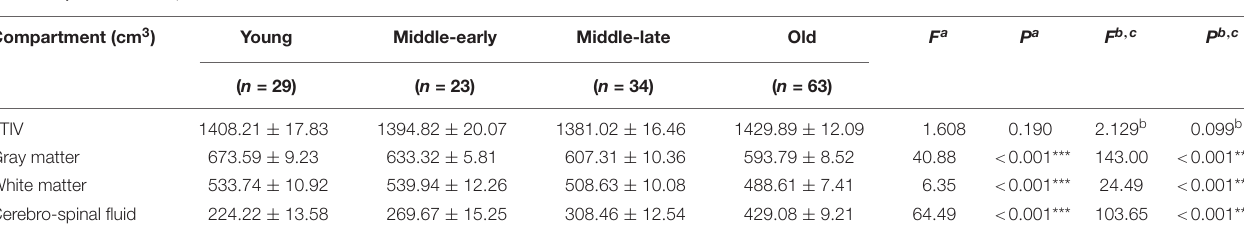
TABLE 2 | Cerebral compartment